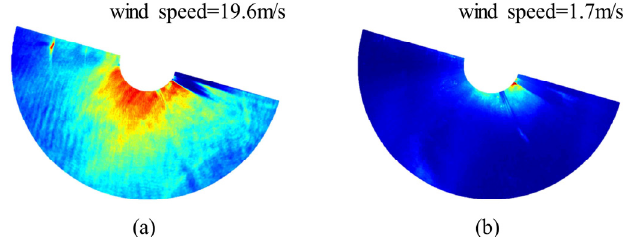
Figure 2. Static feature images of sea surface under different wind speeds, different color areas as the bar of Fig.4, the obtaining process is in the Section 2.2.2. ( a ) The wind speed during measurement was 19.6 m/s; ( b ) the wind speed during measurement was 1.7 m/s.